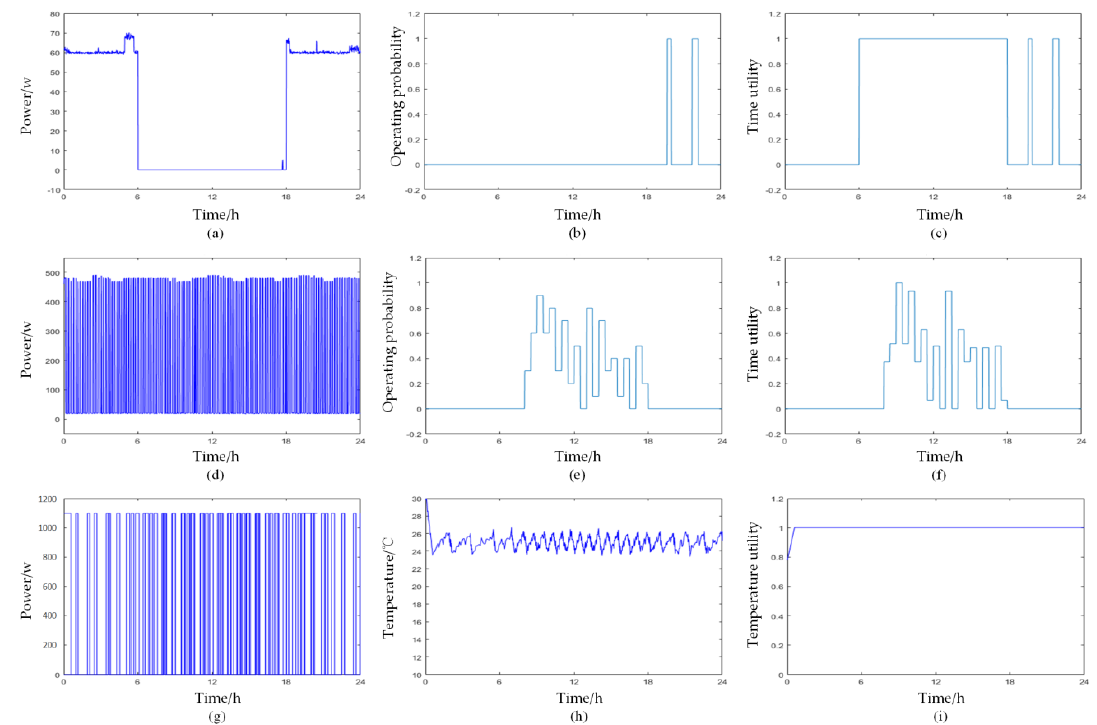
Figure 5. Utility evaluation of the test electrical appliances. ( a ) Light-power. ( b ) Time demand of lighting. ( c ) Time utility for lighting. ( d ) Water dispenser power. ( e ) Time demand of a water dispenser. ( f ) Time utility of a water dispenser. ( g ) Air conditioning power. ( h ) Indoor temperature. ( i ) Temperature utility of air conditioning.